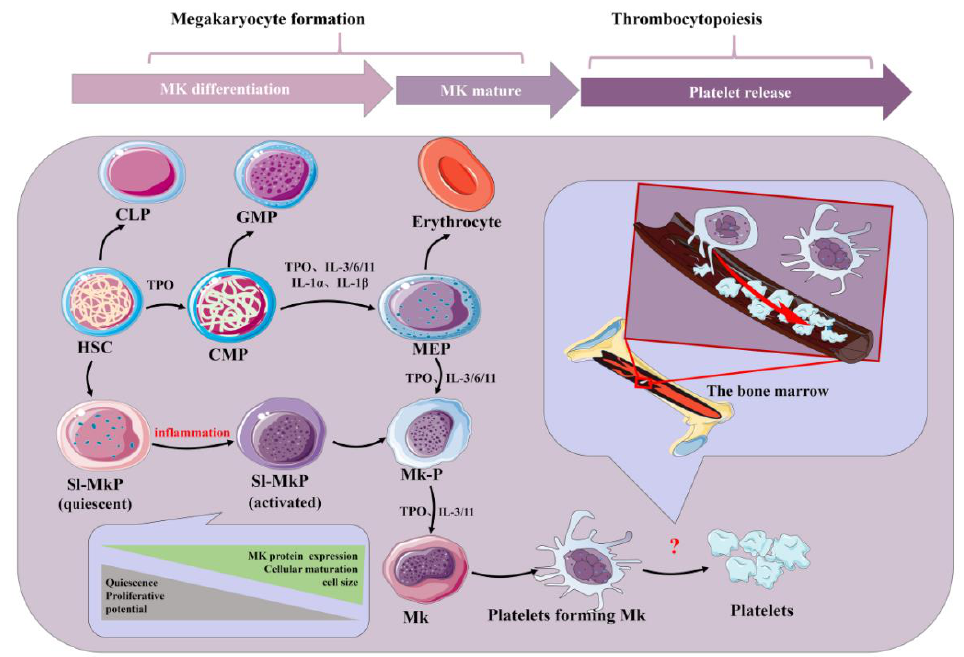
Figure 1. Schematic of platelet production. Inflammatory factors play an important role in the formation of platelets by bone marrow hematopoietic stem cells under physiological and inflammatory conditions. Acute inflammation can drive efficient cell cycle activation and maturation of SL-MKPs to rapidly replenish platelet pools. HSC: hematopoietic stem cell; CLP: common lymphoid progenitor; GMP: granulocyte-macrophage progenitor; CMP: common myeloid progenitor; MEP: megakaryocyte-erythroid progenitor; Mk-P: megakaryocyte progenitor; Sl-Mkp: stem-like megakaryocyte progenitors; TPO: thrombopoietin; MK: megakaryocyte; IL: interleukin.